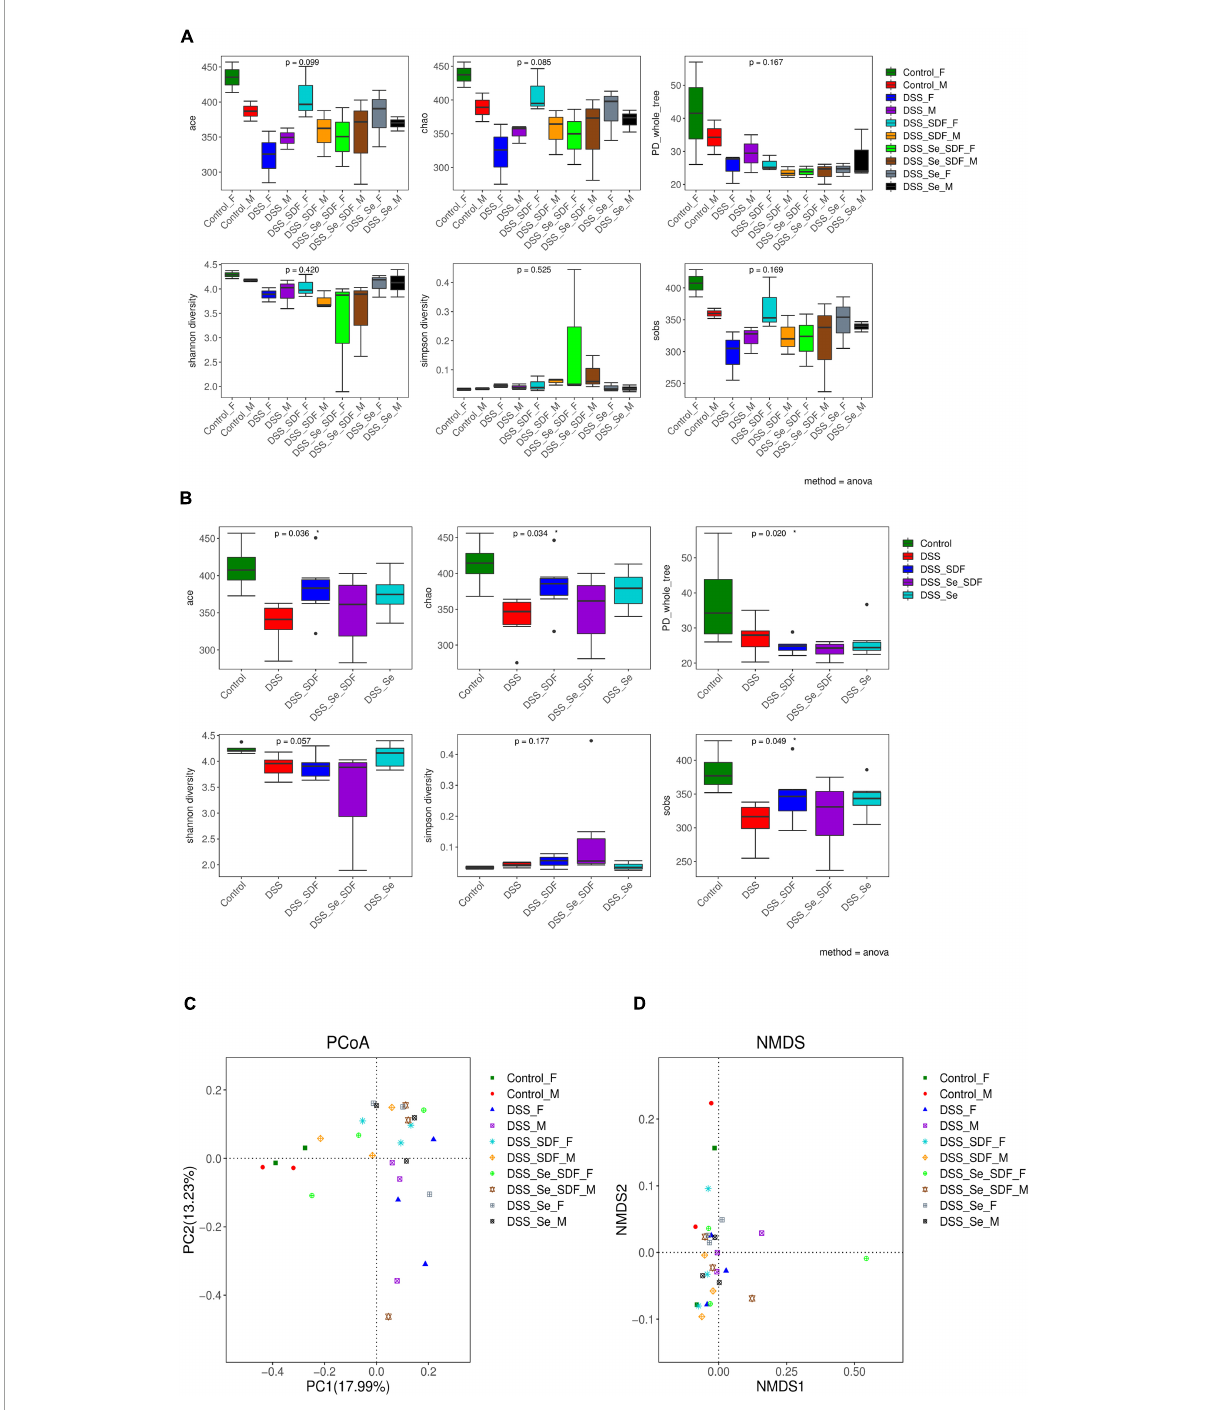
FIGURE4 Effects of Se-SDF on gut microflora diversity in mice with DSS-induced colitis. Analysis of α - diversity in male and female mice (A) and the overall analysis (B) . Analysis of β - diversity of PCoA in male and female mice (C) and the NMDS analysis (D) .